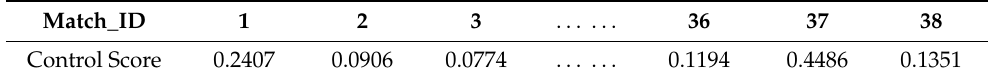
Table 4. Team control